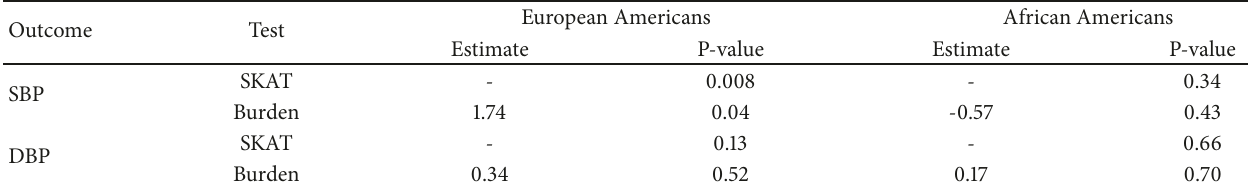
Table 6: Gene-based tests for the association of FMO3 with SBP and DBP.